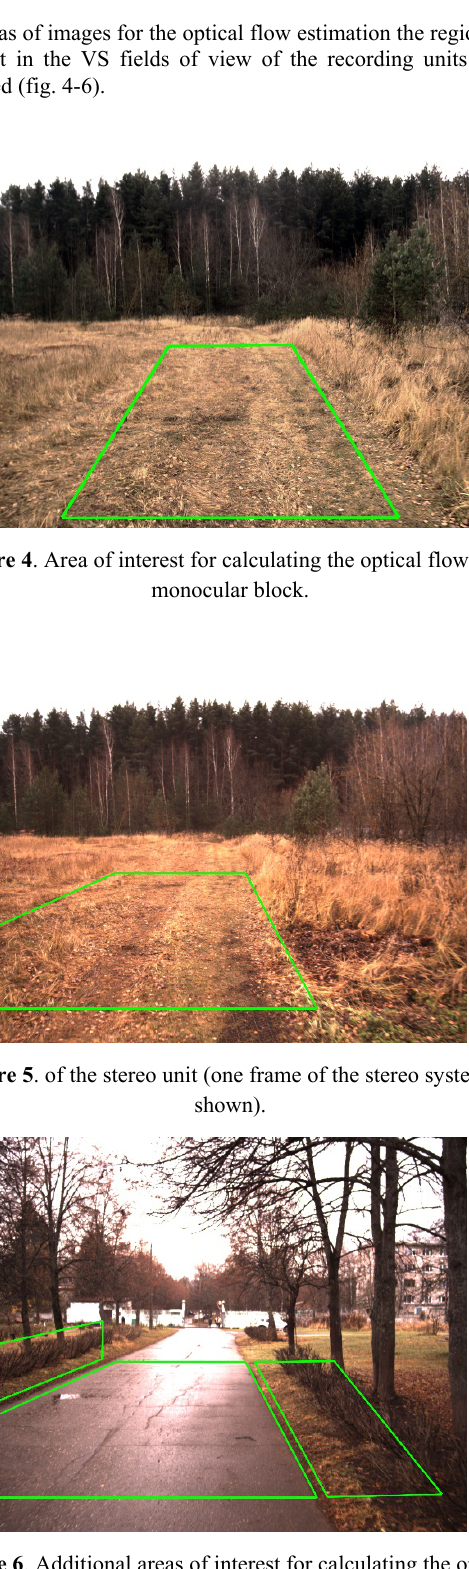
Figure 6 . Additional areas of interest for calculating the optical flow in the case of a homogeneous underlying surface (a single frame of the stereo system is shown).